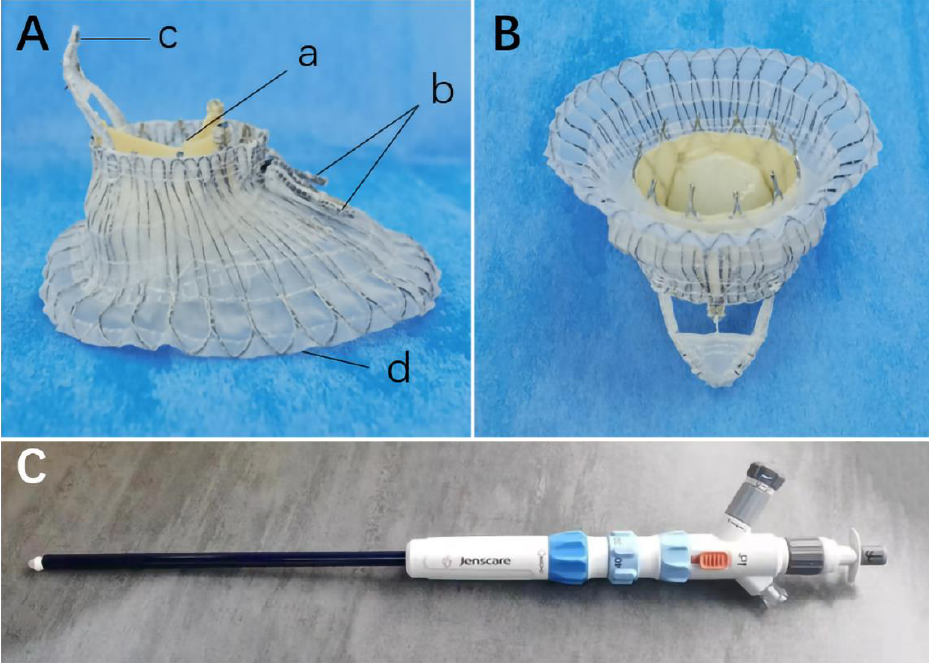
Figure 1. The LuX-Valve system. ( A ) The side view of LuX-Valve (a) bovine pericardial trileaflet (b) two anterior leaflet graspers (c) a bird tongue-shaped ventricle septum anchoring device (d) an atrial disc. ( B ) The atrial view of LuX-Valve. ( C ) The delivery system.